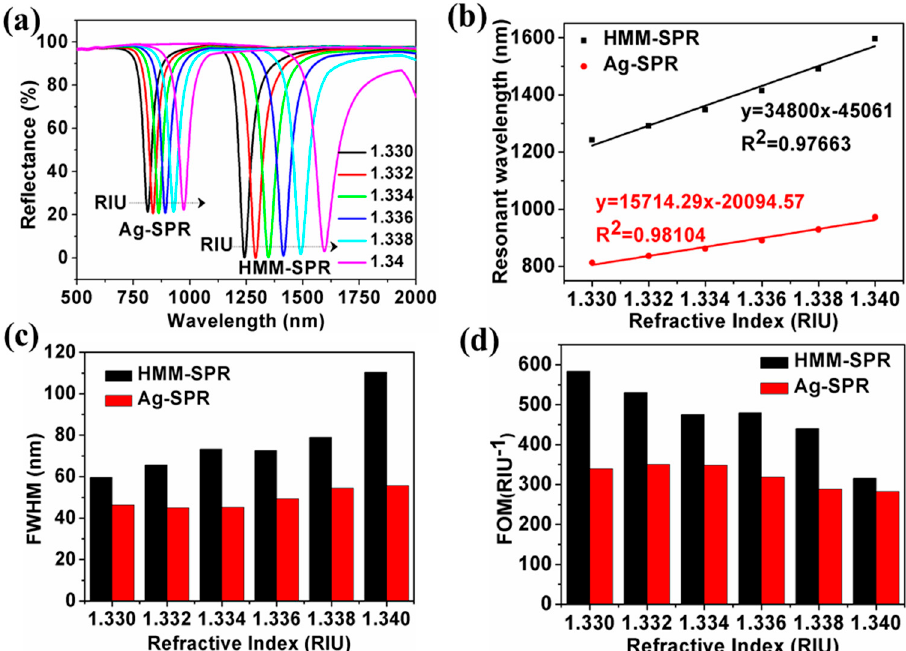
Figure 8. The dependence of the reflectance on the refractive index for the HMM-SPR ( a ) and Ag-SPR sensor ( b ). Comparison of the resonant wavelength ( c ). Comparison of S ( d ).